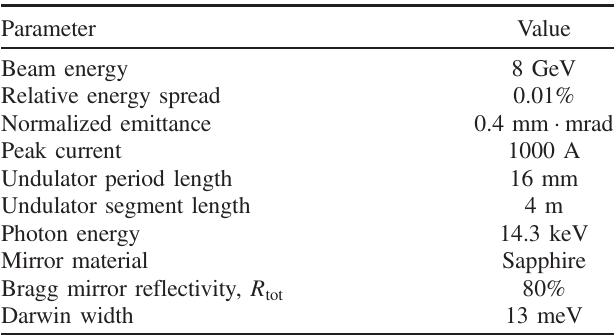
TABLE I. The main parameters of XFELO operation for SHINE.